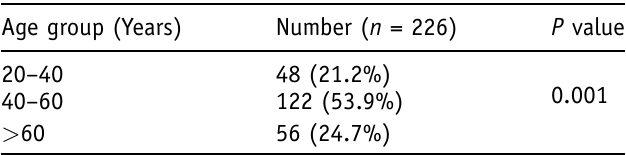
Table I. Age wise distribution of cases.